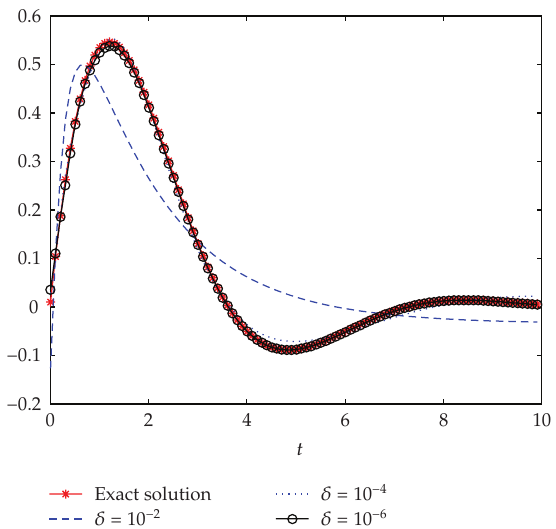
Figure 5: Example 3.5: the stability of the approximate solution.